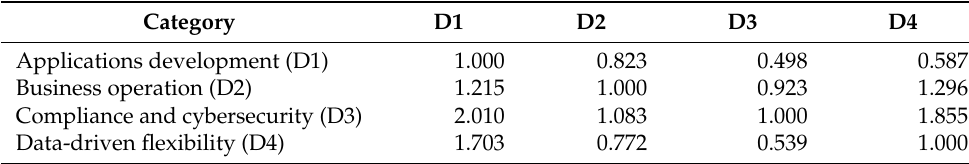
Table 6. Consolidated decision matrix for main CSF dimensions.